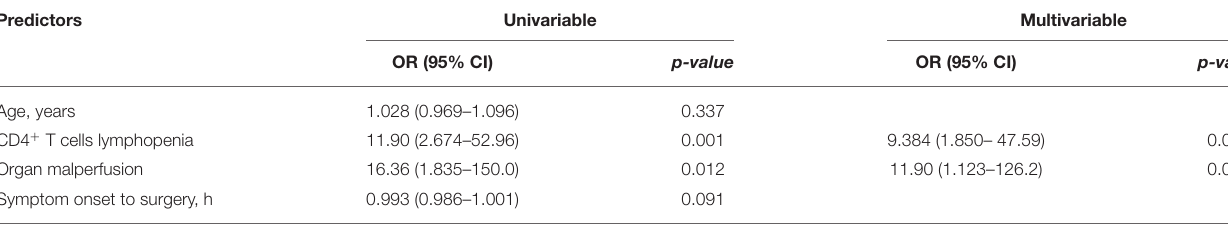
TABLE 5 | Univariable and multivariable logistic regression analysis of possible predictors of MAE in prospective cohort. Predictors Univariable Multivariable OR (95% CI) p-value OR (95% CI)